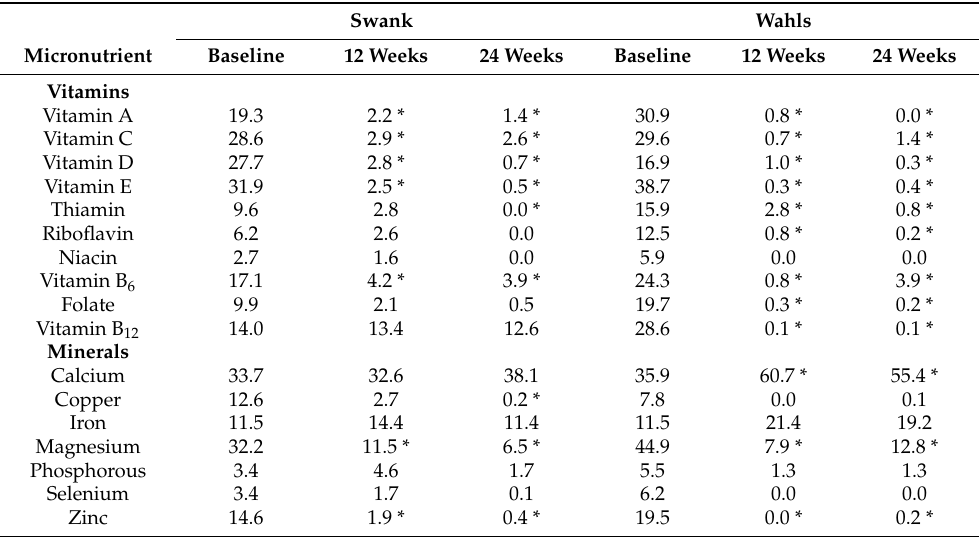
Table 3. Proportion with inadequate micronutrient intake from food and supplements at baseline and after adapting the Swank or Wahls diets among individuals with RRMS 1,2 . Swank Wahls Micronutrient Baseline 12 Weeks 24 Weeks Baseline 12 Weeks 24 Weeks Vitamins Vitamin